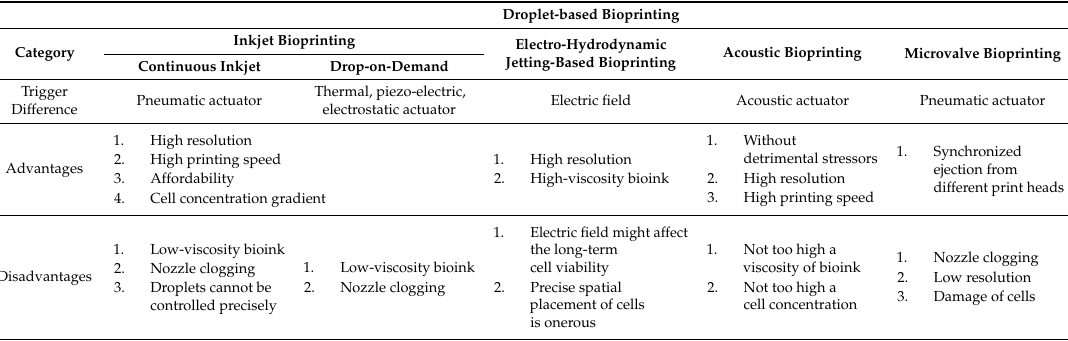
Table 2. The comparison among droplet-based bioprinting